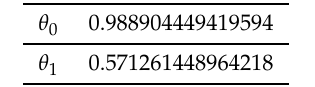
Table 3. Learning parameters for the Ω D (cid:48) [ k ]